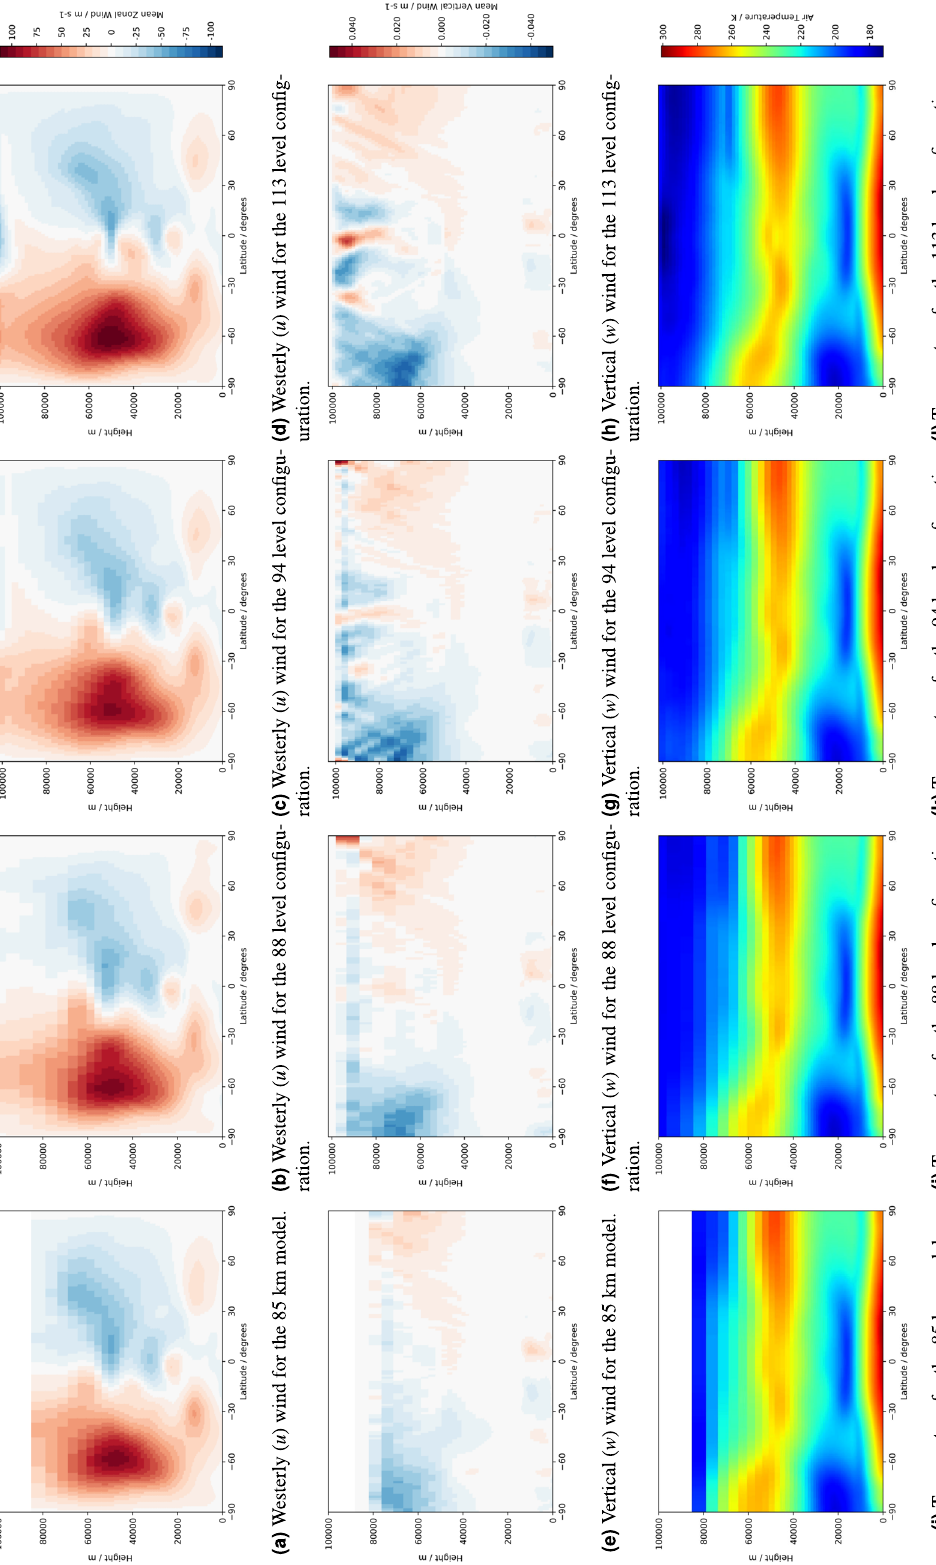
Fig. 13. Zonal mean monthly mean climatologies in June of westerly ( u ) wind (top), vertical ( w ) wind (middle) and temperature (bottom) comparing the original 85 km model with the 88, 94 and 113 level con fi